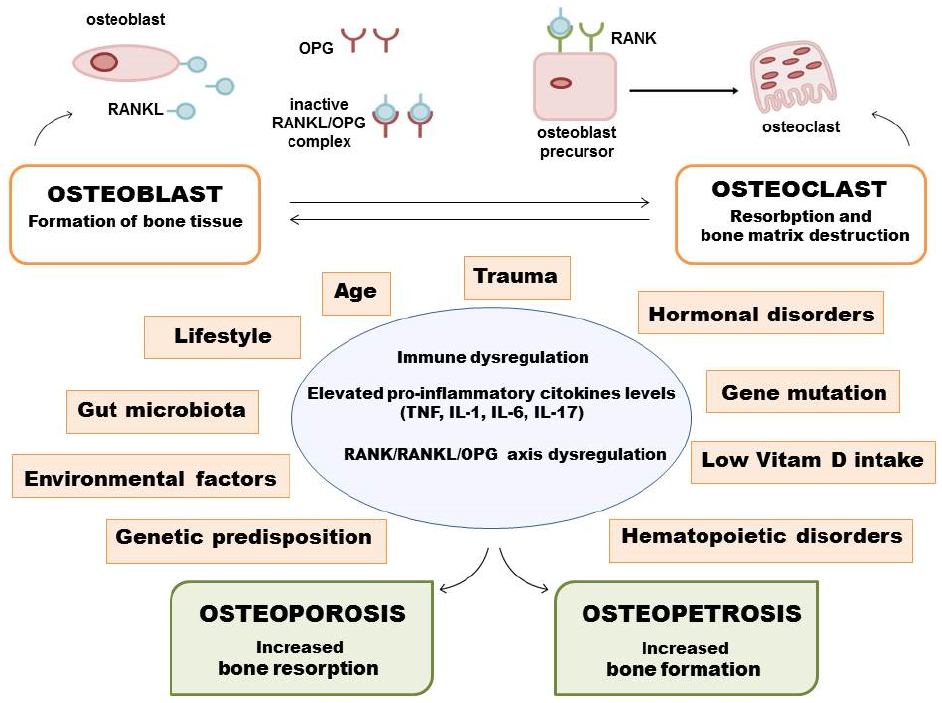
Figure 1. Risk factors for